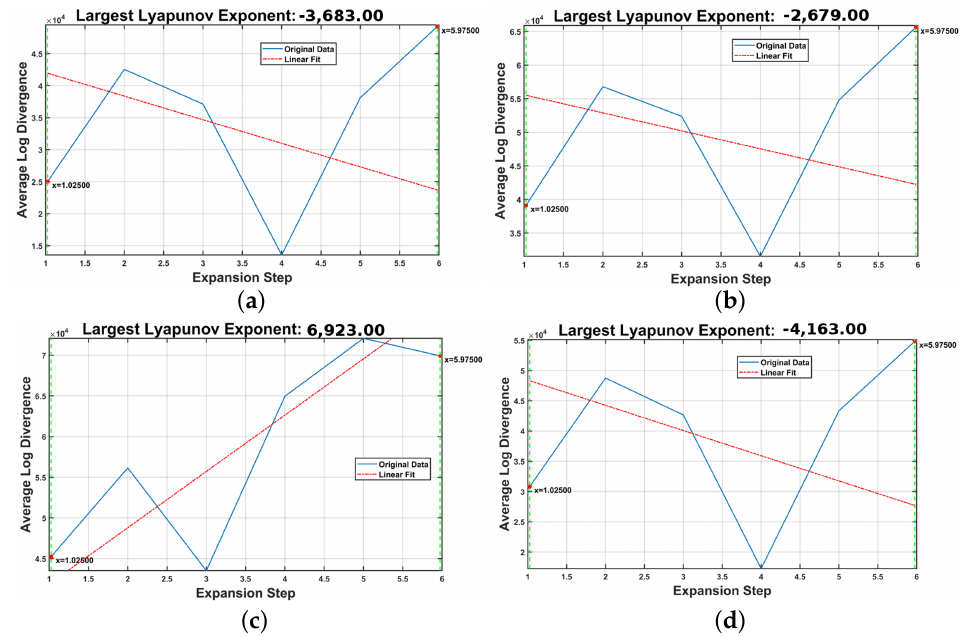
Figure 5. LLE for several signals from the CP dataset. ( a ) LLE for class P1, ( b ) LLE for class P6, ( c ) LLE for class P10, ( d ) LLE for class P13.